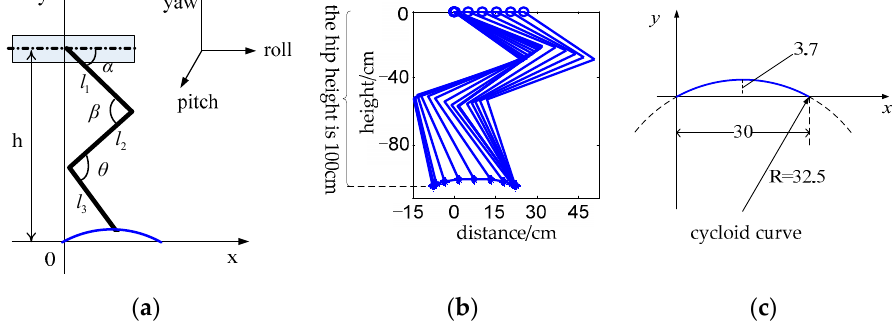
Figure 14. Foot trajectory of robot. ( a ) Structure diagram of one leg. ( b ) Experimental prototype of quadruped robot. ( c ) The analytic coordinates of foot trajectory.